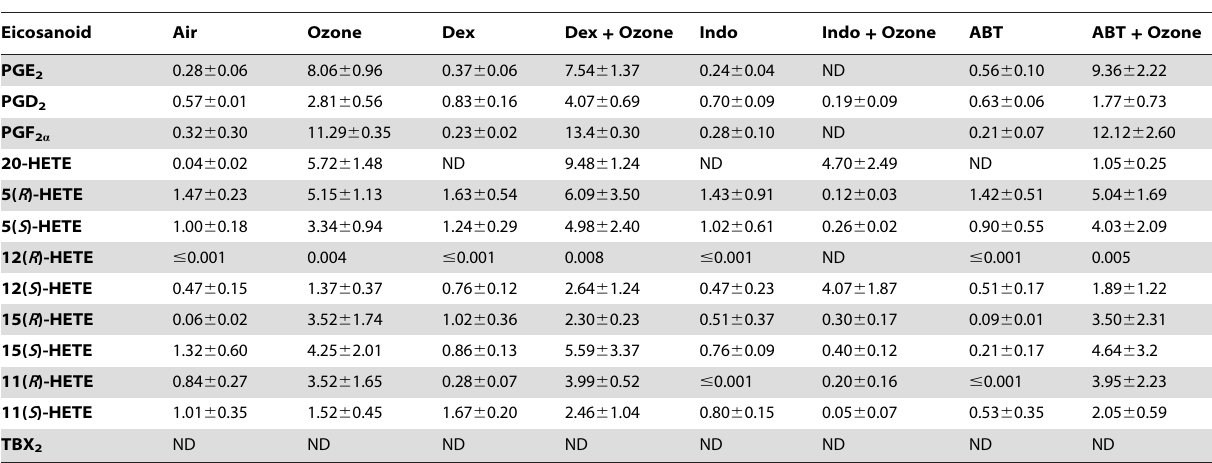
Table 1. Level of eicosanoids in murine BAL fluid following ozone exposure.